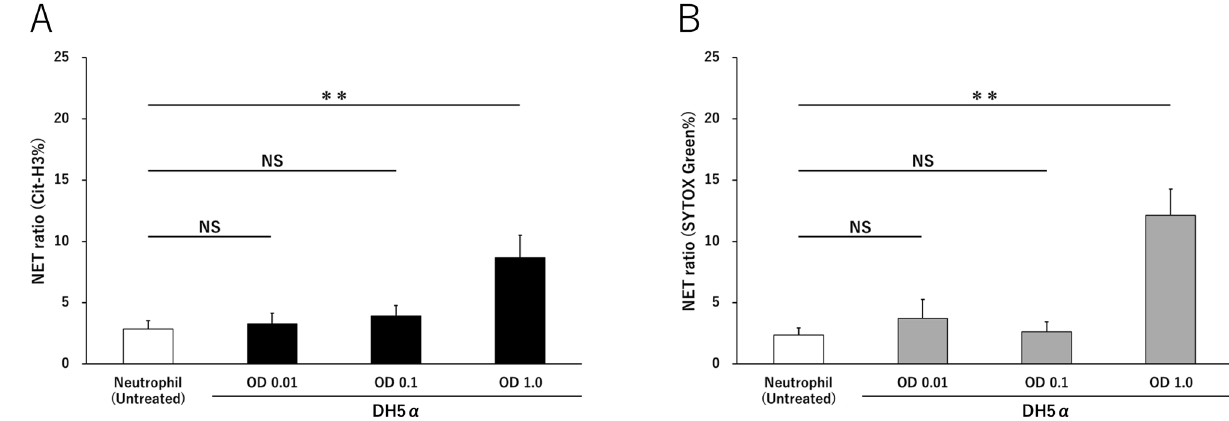
Figure 1. NETs increase in concentration-dependent manner after DH5α stimulation. NETs were induced in a concentration-dependent manner by bacterial (DH5α) stimulation. ( A , B ) DH5α cells were incubated with neutrophils for 4 h under platelet-free conditions, and Cit-H3 and nuclear released into the extracellular space were measured as NET ratio. ** p < 0.001, when compared with untreated neutrophils. Data represent the mean values ± SD of at least three experiments. NS, not